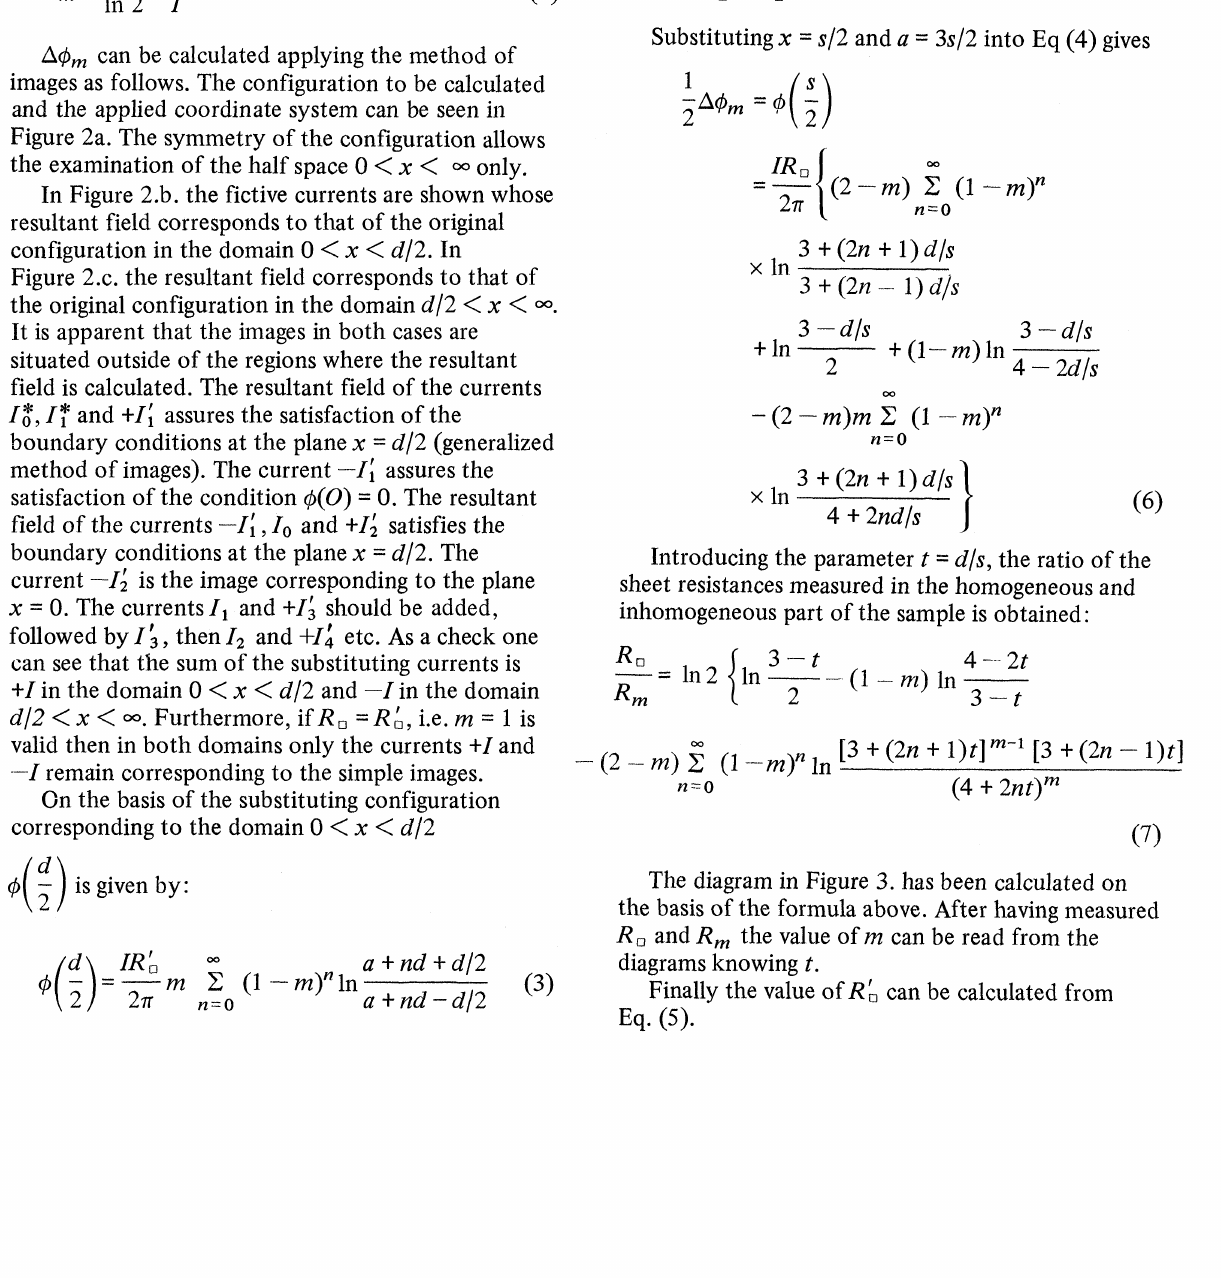
FIGURE Measurement of R m (apparent sheet